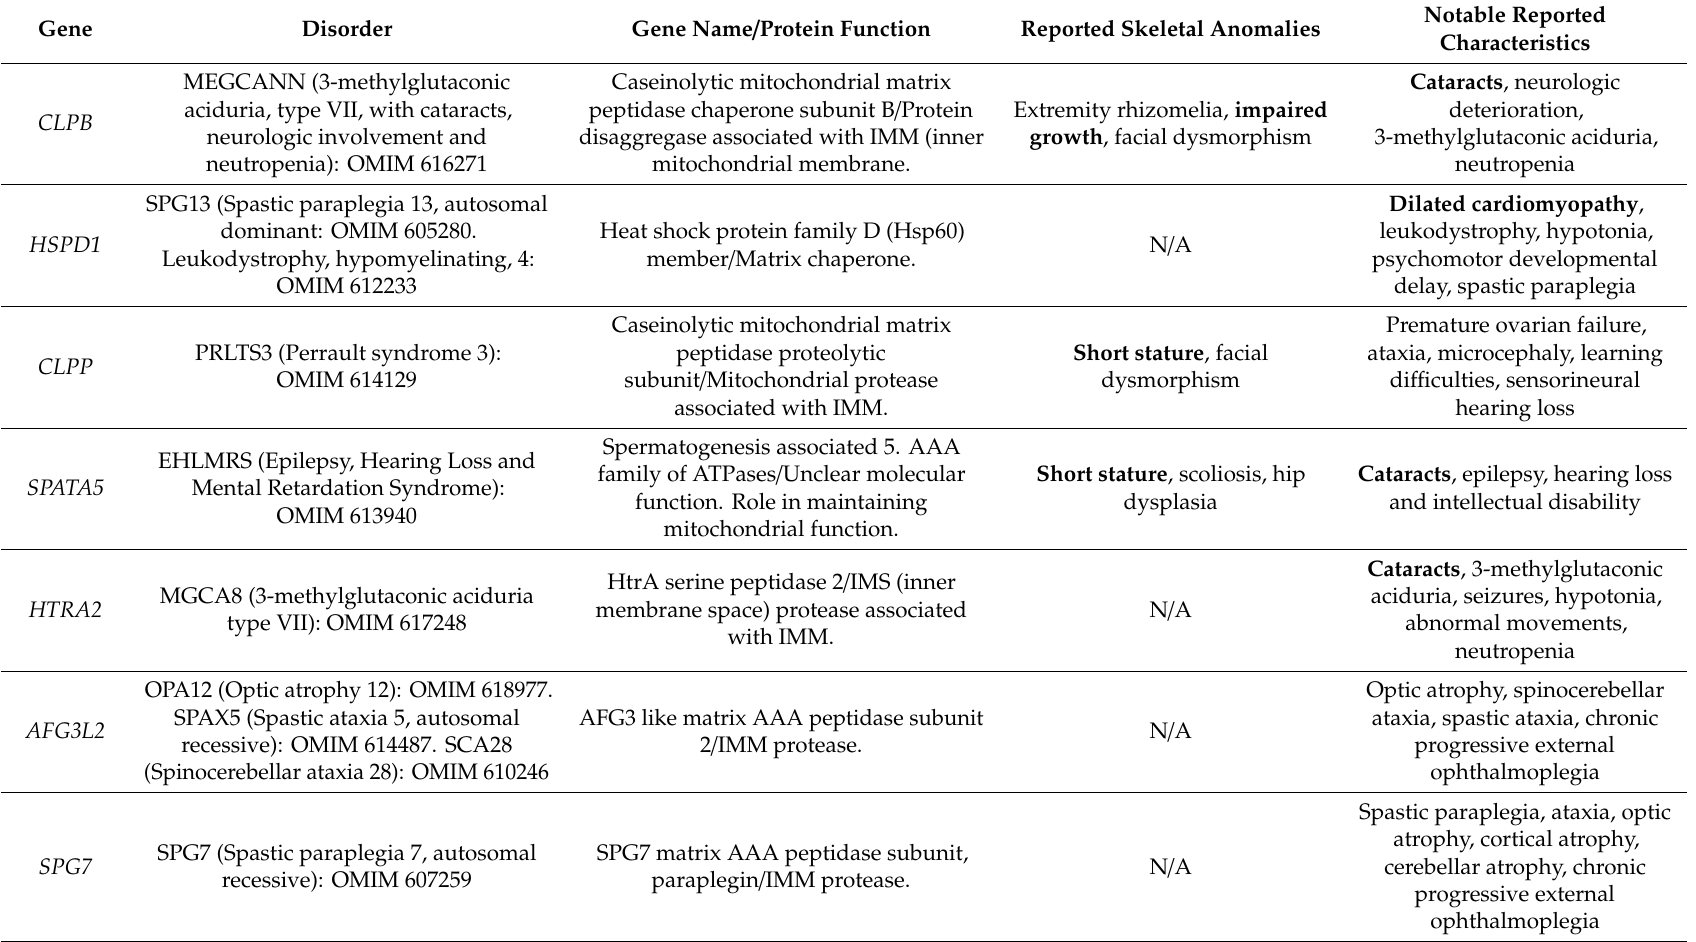
Table 2. Genes encoding mitochondrial proteases and chaperones implicated in mitochondrial disease, indicating formal OMIM (Online Mendelian Inheritance in Man) disease designations, gene names, protein functions, and phenotypic descriptions. Disease phenotypes indicted in bold are also common in mitochondrial skeletal